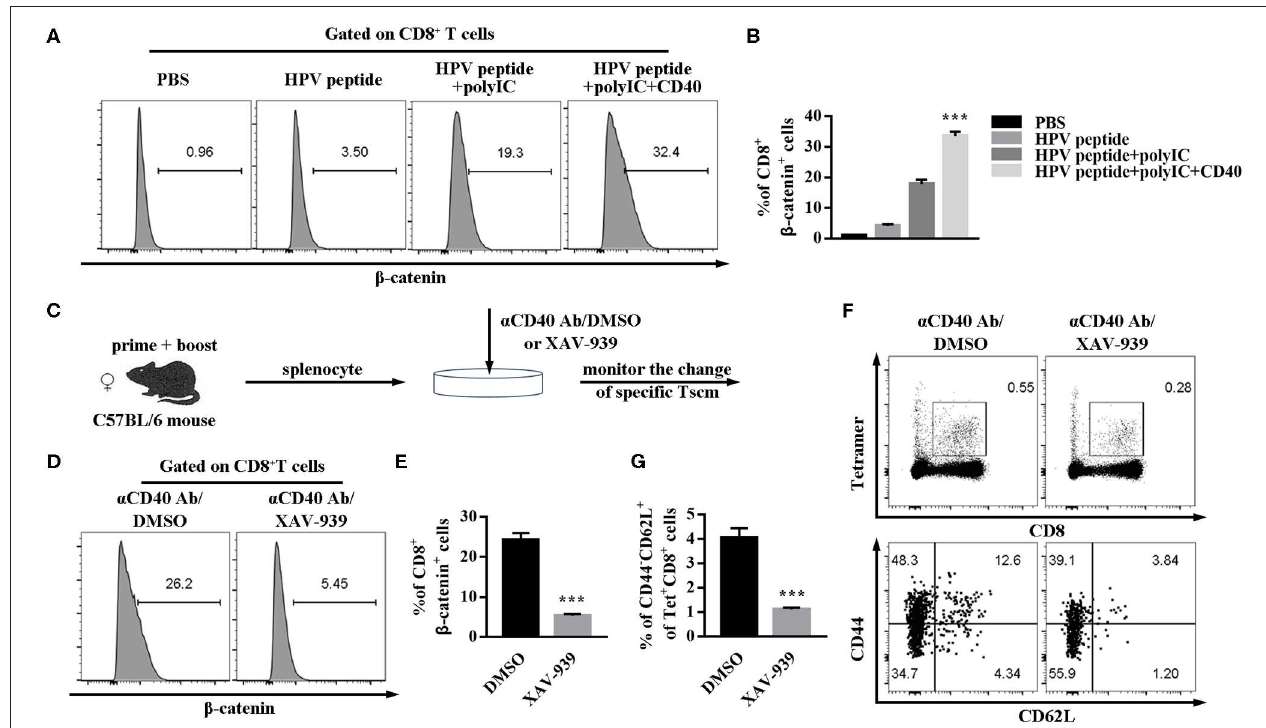
FIGURE 5 | CD40 regulates Wnt/ β -catenin signaling to elicit a high level of HPV16-specific CD8 Tscm cells. (A,B) Flow analysis of β -catenin in CD8 + T cells from C57BL/6 mice immunized by different vaccination strategies. (C) Splenocytes from immunized mice were treated with aCD40mAb plus DMSO or aCD40mAb plus XAV-939 for 48h, then the percentage of β -catenin in CD8 + T cells was measured (D,E) and HPV16 E7 specific CD8 + Tscm cells (F,G) was detected by FCS analysis. Error bars represent the mean ± SD of three independent experiments. *** p <